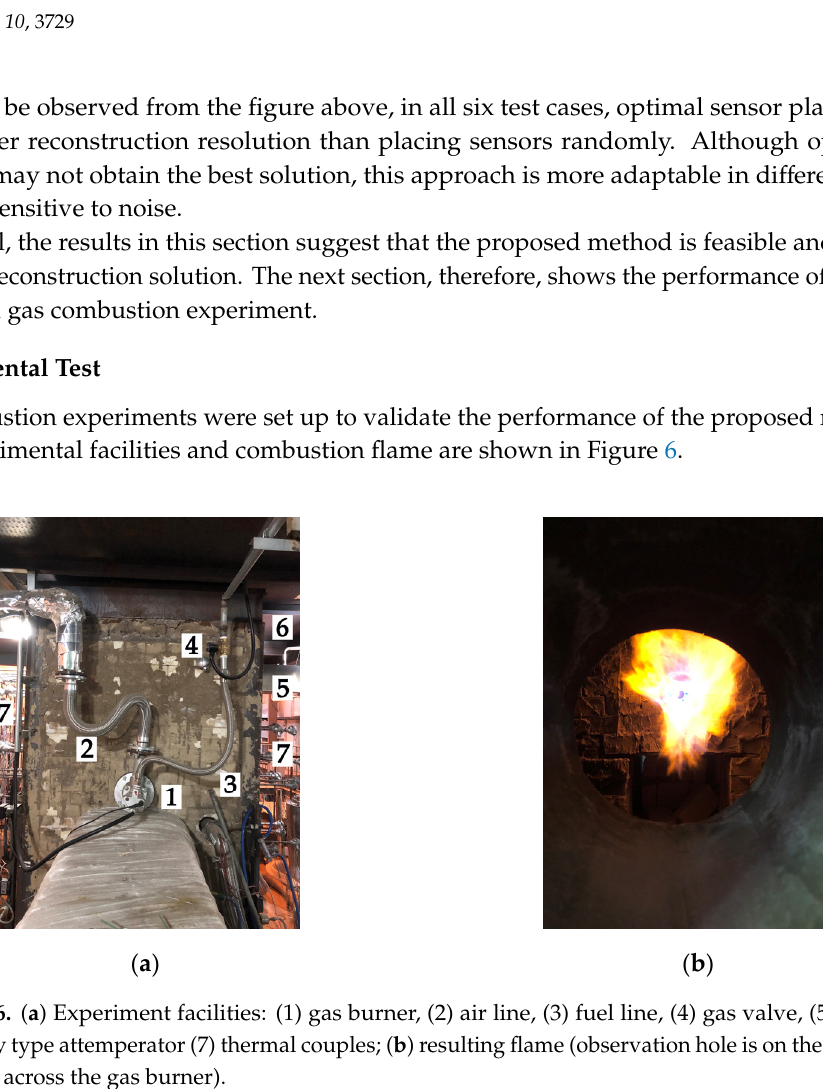
Figure 7. Layout of the combustion system. (1) Compressed gas cylinder, (2) gas valve, (3) gas flowmeter, (4) air fan, (5) air valve, (6) hotwire anemometer, (7) gas burner, (8) thermal couples, (9) combustion chamber, (10) induced draft fan, and (11) observation hole.